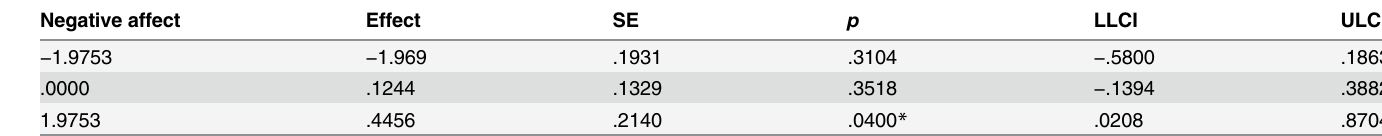
Table 1. The effect of 2013 Boston Marathon Bomb prime on verbal fusion.